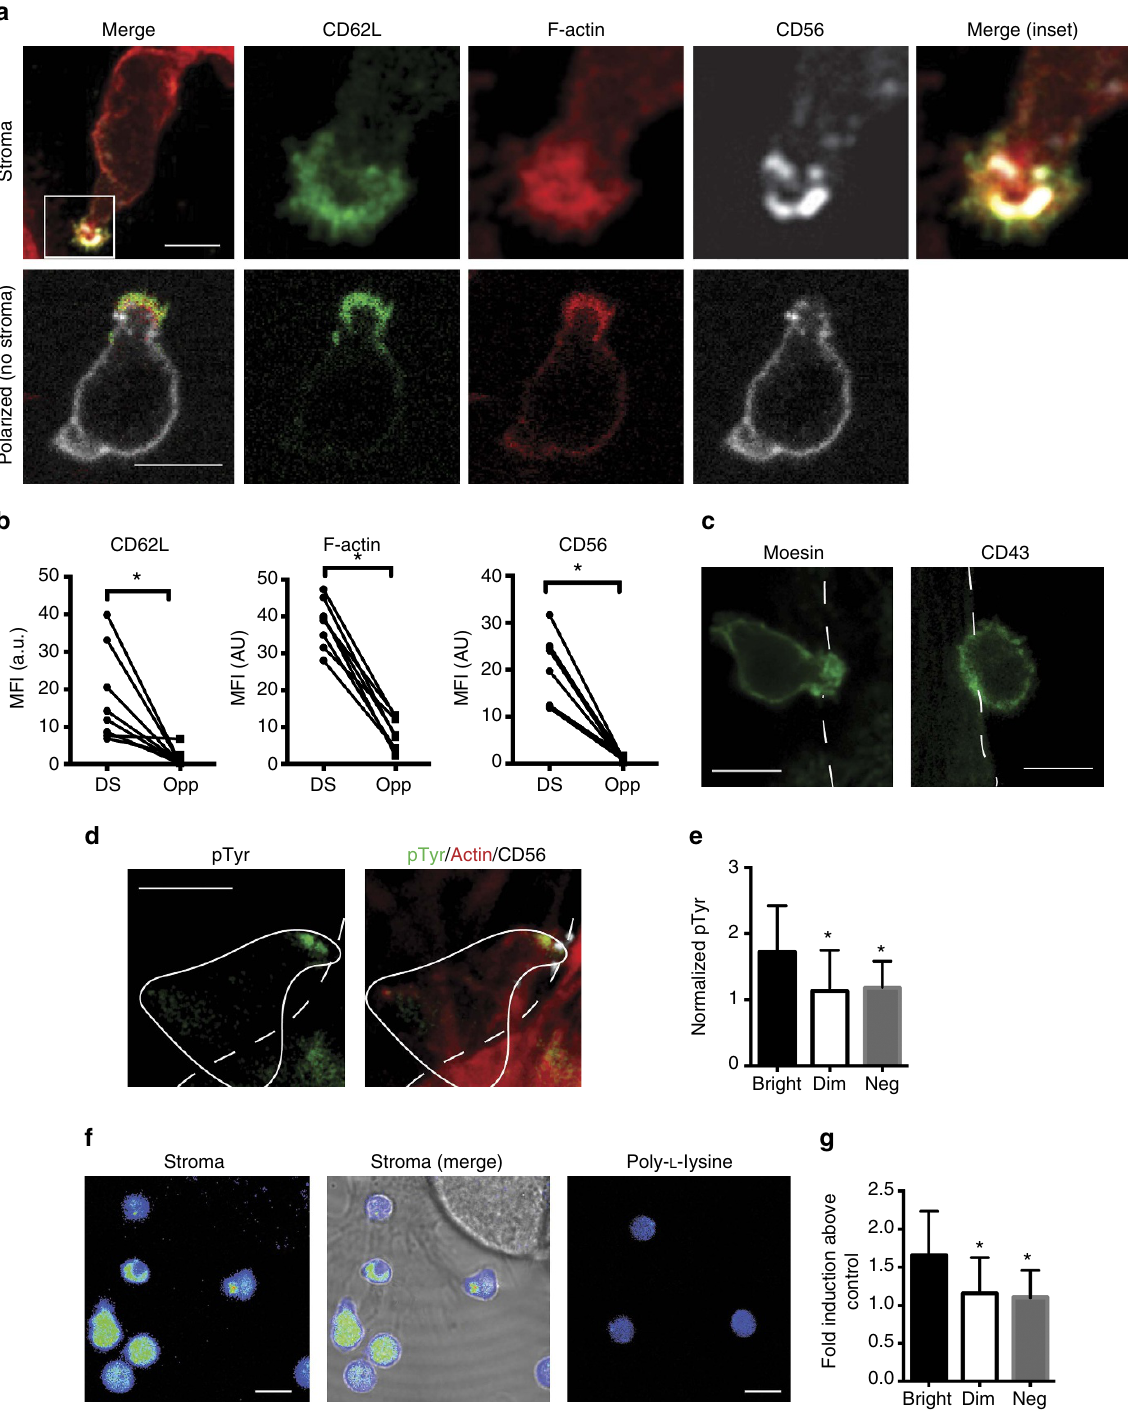
Figure 3 | Fixed-cell confocal microscopy defines the DS. ( a ) CD56 bright NK cells were incubated on EL08.1D2 stromal cells (top) or gelatin-coated imaging chambers (bottom) for 2h then fixed, permeabilized and stained for proteins of interest as indicated. Images were acquired by confocal microscopy and analysed as described in Methods. Scale bar, 5 m m. ( b ) Density of CD56, F-actin and CD62L were calculated from confocal microscopy images by measuring fluorescence intensity at the DS or opposite side (opp.). n ¼ 13 from one experiment representative of three independent repeats. * P o 0.05 by Student’s unpaired t -test. ( c ) CD56 bright NK cell tethered to a stromal cell (outlined in dashed line) with CD43 (right) or moesin (left) (green). Scale bar, 5 m m. ( d ) CD56 bright NK cell (outlined in solid line) tethered to a stromal cell (outlined in dashed line) with phospho-tyrosine (green), F-actin (red) and CD56 (grey) detected. Scale bar, 3 m m. ( e ) Accumulation of pTyr staining at the DS in purified CD56 bright , CD56 dim or CD56 neg NK cells conjugated to stromal cells as in c . Values are normalized to the distal portion of the cell body as described in Methods. n ¼ 40 cells per condition. Data are represented as mean ± s.d. * P o 0.0001 by Student’s unpaired t -test compared with CD56 bright . ( f ) Representative field showing CD56 bright NK cells adhered to stromal cells (left and center, with brightfield) or poly- L -lysine (right) with heat map intensity of Ca 2 þ flux as detected by Indo1-AM. Scale bar, 10 m m. ( g ) Ratio of 485/530nm intensity (normalized to mean ratio of poly- L -lysine control) of purified CD56 bright , CD56 dim or CD56 neg NK cells on stroma. Data are represented as mean ± s.d. * P o 0.0001 by Student’s unpaired t -test compared with CD56 bright . n ¼ 170 cells per condition. NATURE COMMUNICATIONS|7:12171|DOI: